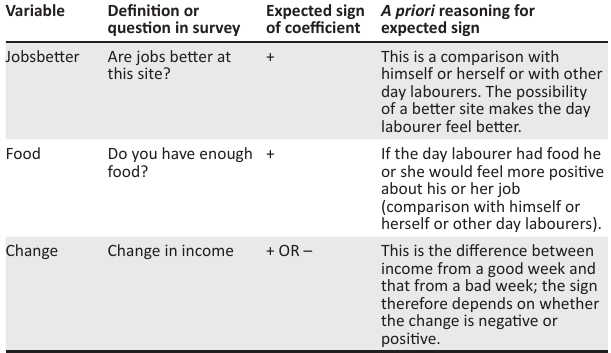
TABLE 10: Comparison variables.